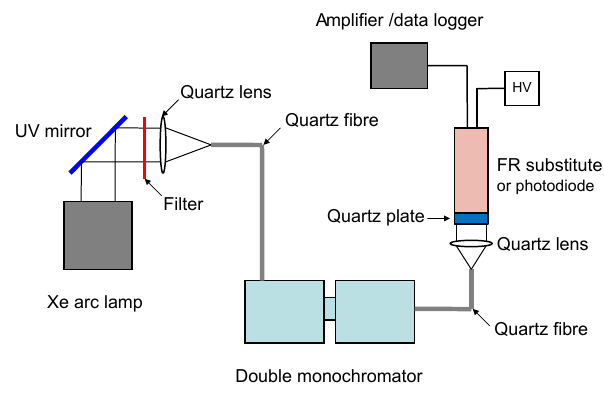
Figure 2. Scheme of the laboratory setup for spectral sensitivity